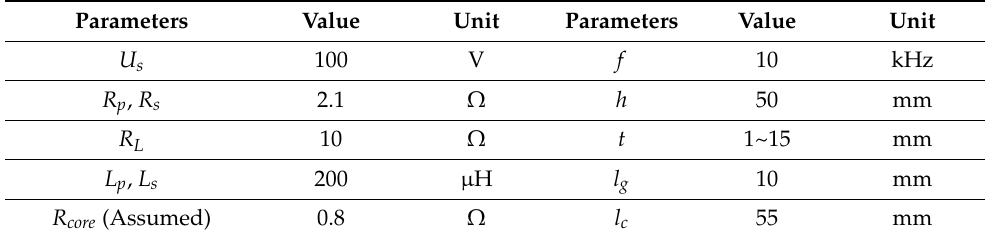
Table 2. Key design parameters of traditional couplers in a 2D simulation.